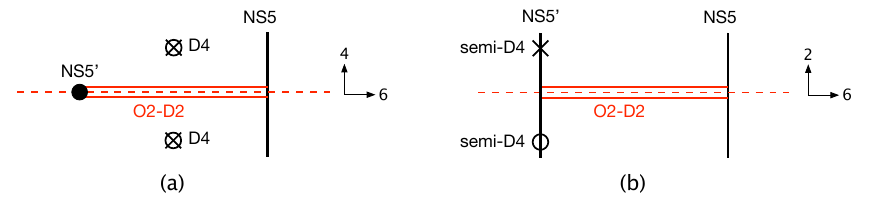
Figure 6 . (a) Complex mass (b) Twisted